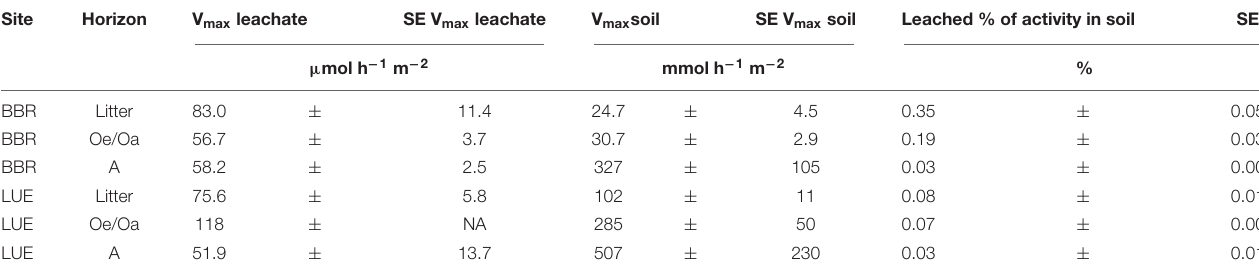
TABLE 4 | Potential phosphomonoesterase activity (V max ) in leached soil solutions and soil extracts from unfertilized plots per horizon and square meter. Site Horizon V max leachate SE V max leachate V max soil SE V max soil Leached % of activity in soil